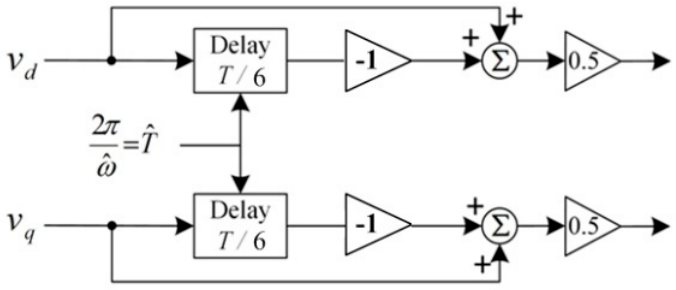
Figure 6. Simplified time-domain implementation of the MDSC.